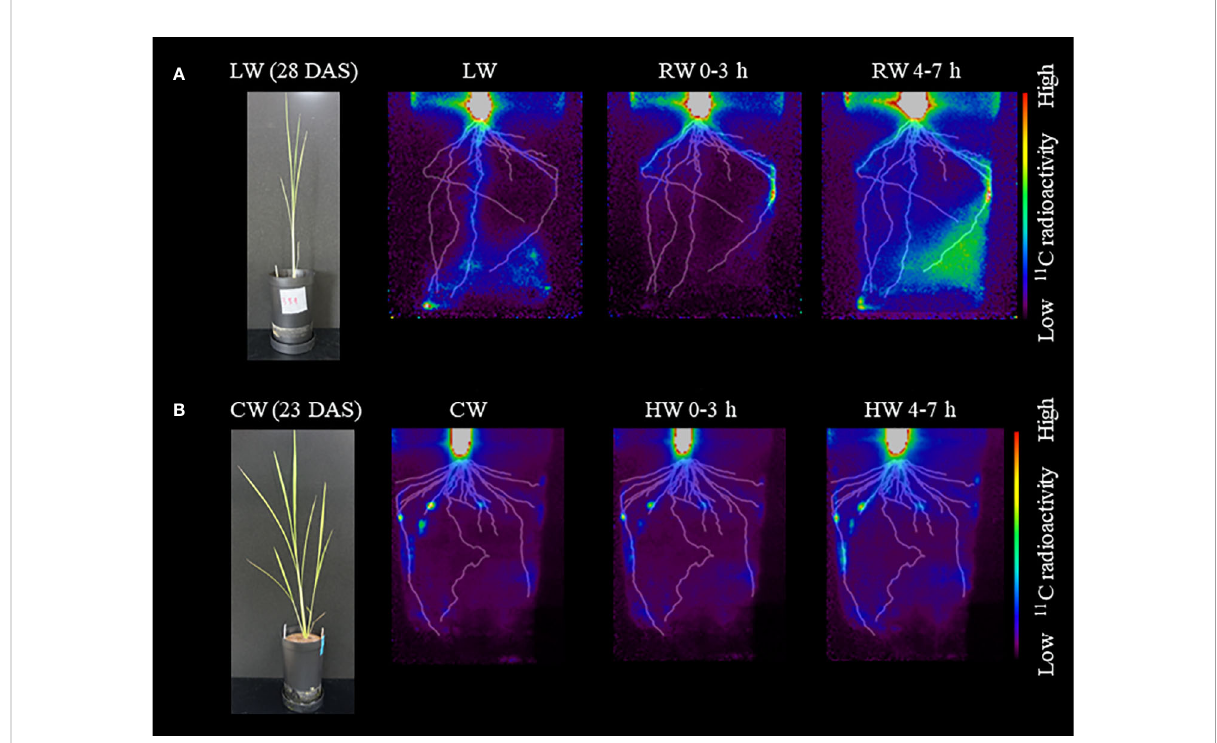
FIGURE 5 Typical images obtained from PETIS imaging experiments under (A) low water content (LW), recover water content 0-3 h (RW 0-3 h), and recover water content 4-7 h (RW 4-7 h). Photograph of rice plant before the start of PETIS imaging at 28 DAS is also shown. PETIS images under (B) control water content (CW), high water content 0-3 h (HW 0-3 h), and high water content 4-7 h (HW 4-7 h). Photograph of rice plant at 23 DAS is also shown. Fused images show the distribution of 11 C-photosynthates obtained from PETIS imaging and the root system architecture (RSA) obtained from X-ray CT under each treatment viewed from the front of the pot. The monochrome images show the RSA, and the color images show the distribution of 11